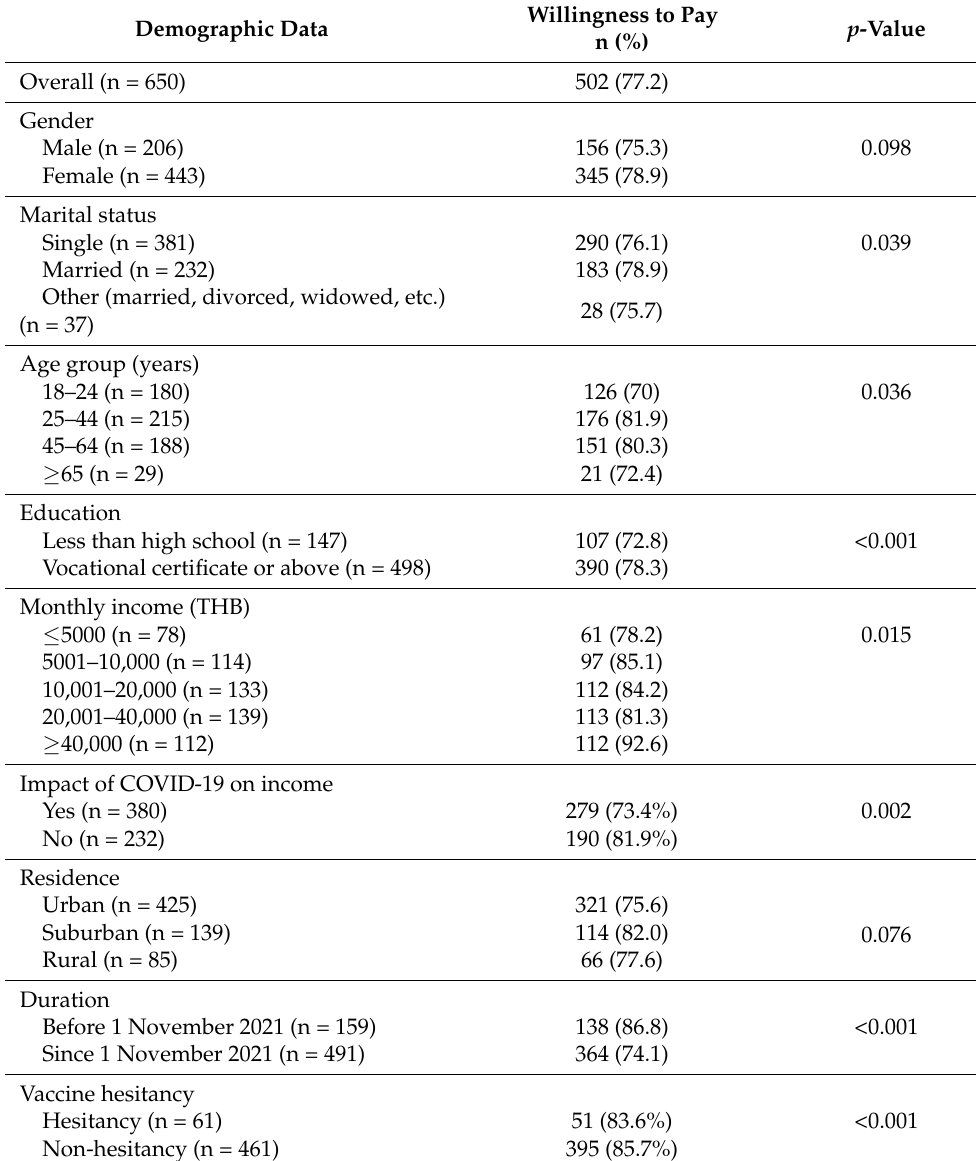
Table 5. Relationship between demographic characteristics, vaccine hesitancy, and percentage of willingness to pay for the COVID-19 vaccine (n =